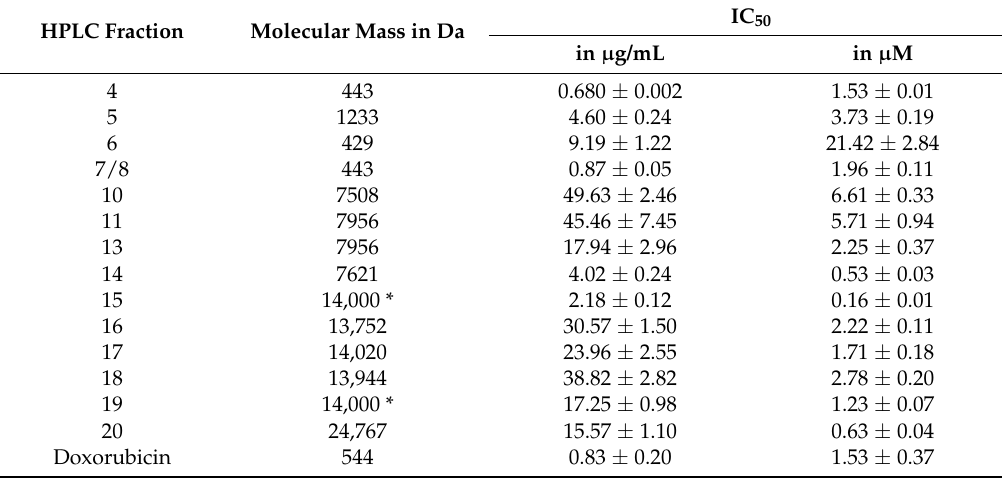
Table 4. IC 50 values of P. flavoviridis venom fractions against SH-SY5Y cells. Single RP-HPLC venom fractions of P. flavoviridis were tested against human neuroblastoma SH-SY5Y cells, the half maximal inhibitory concentrations (IC 50 ) were determined in µ g/mL, and the molar concentration in µ M, regarding the most abundant molecular mass, were determined in Da. Doxorubicin was used as a reference and error mean in ± SD.